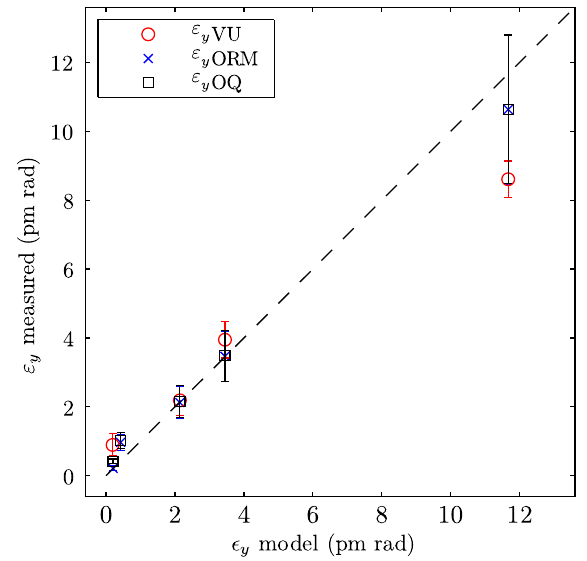
FIG. 9. Measurement of vertical emittance, using orbit bumps Þ and orbit response matrix through vertical undulator ð ε y VU Þ . The vertical emittance measured fitting with LOCO [23] ð ε y ORM Þ using orbit response matrices is also shown in quadrature ð ε y OQ with the contribution from the quantum limit. A dashed line −− is used to indicate measured vertical emittance equal to the